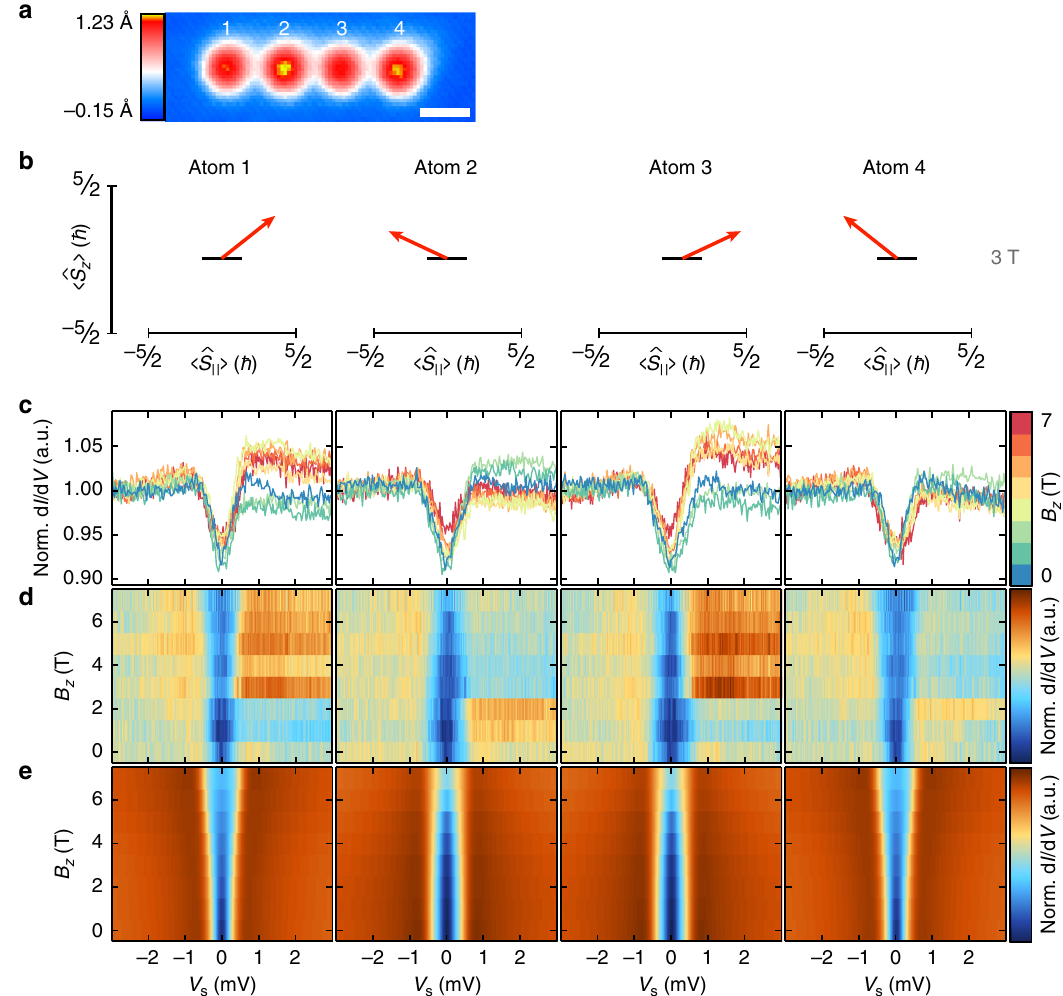
Fig. 3 Non-collinear spin state in the Fe 4 chain with d NN = 3 a . a SPSTM topograph of the Fe 4 chain measured at B z = 3 T ( V s = − 6 mV, I stab = 0.5 nA). The white scale bar has a length of 1 nm. b Calculated spin-expectation values at B z = 3 T from ED for each atom in the Fe 4 chain, using the parameters given in Table 1, and J NN = − 60 μ eV, D ⊥ ,NN = − 50 μ eV, J NNN = + 15 μ eV, and D ⊥ ,NNN = − 20 μ eV. c , d ISTS spectra taken with a magnetic tip (SP-ISTS, c ) and corresponding colorplots ( d ) measured on all four atoms in the Fe 4 chain in a magnetic fi eld up to B z = 7 T. ( V stab = − 6 mV, I stab = 3 nA, V mod = 40 μ V). e Calculated ISTS from the perturbation theory model using the same parameters as in ( b